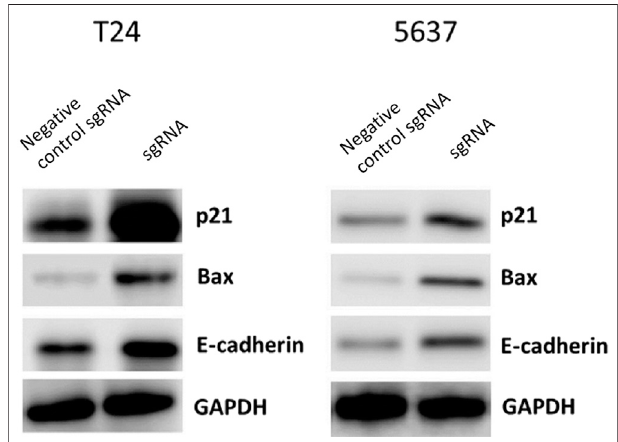
FIGURE 6 | Negative correlation of LINC00341 with p21, Bax and E-cadherin expression. qPCR was employed to assay the expression changes of p21, E-cadherin, as well as Bax in bladder cancers compared to non-tumor tissues (N (cid:2) 36). (A) . Inversely expressed LINC00341 and p21 in bladder cancer. (B) . Inversely expressed LINC00341 and Bax in bladder cancer. (C) . Inversely expressed LINC00341 and E-cadherin in bladder cancer.